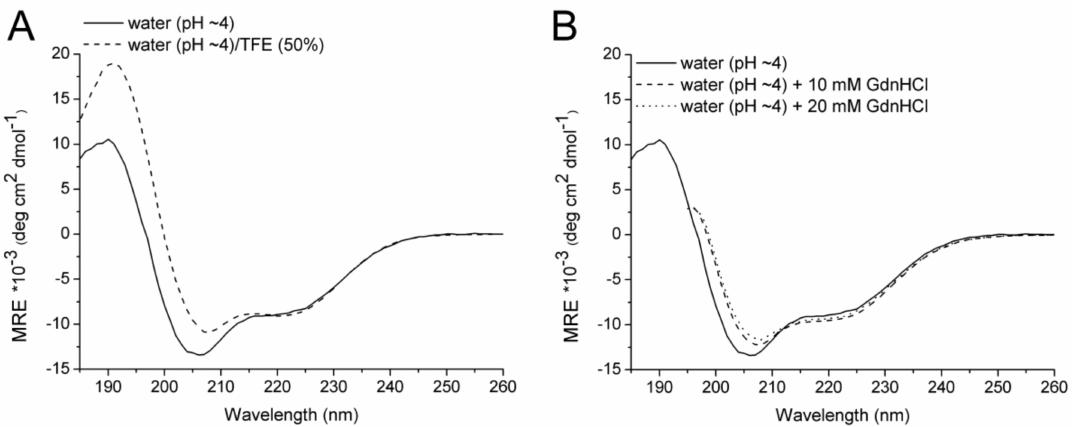
Figure 2. CD spectra of recombinant Id2’ (30 µ M). ( A ) CD curves in pure water (pH~4) or in